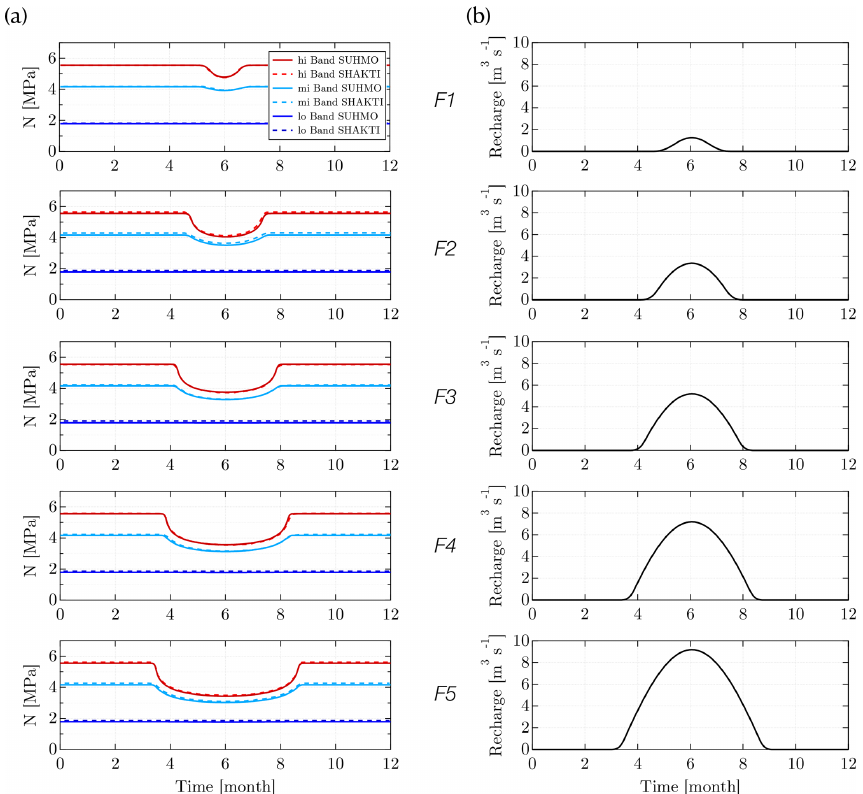
Figure 8. Steady-state results for the SHMIP suite of test cases F: (a) time evolution of the averaged effective pressure N at three locations of interest (see text and Fig. 2b) and (b) time evolution of the seasonal water forcing. For comparison, results from SHAKTI (Sommers et al., 2018) as presented in de Fleurian et al. (2018) are also shown.